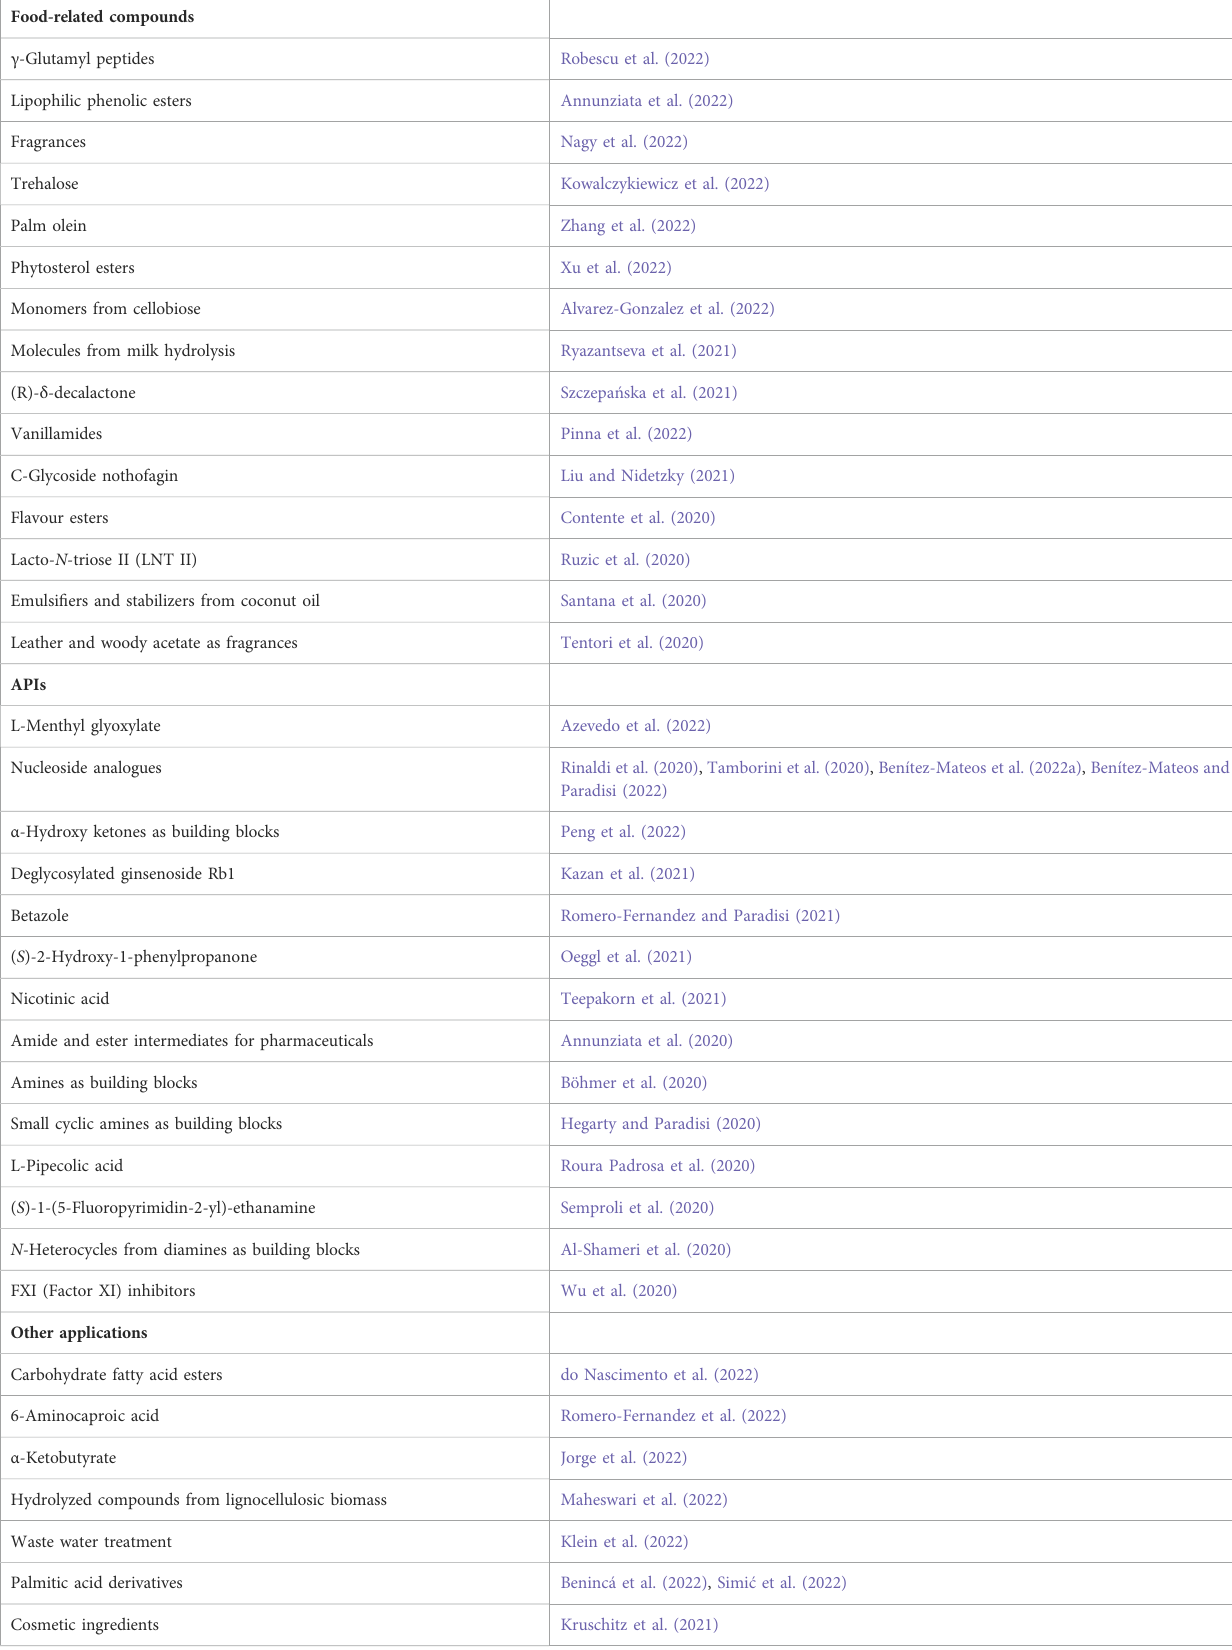
TABLE 1 Selected examples of in fl ow biocatalytic applications (2020 –